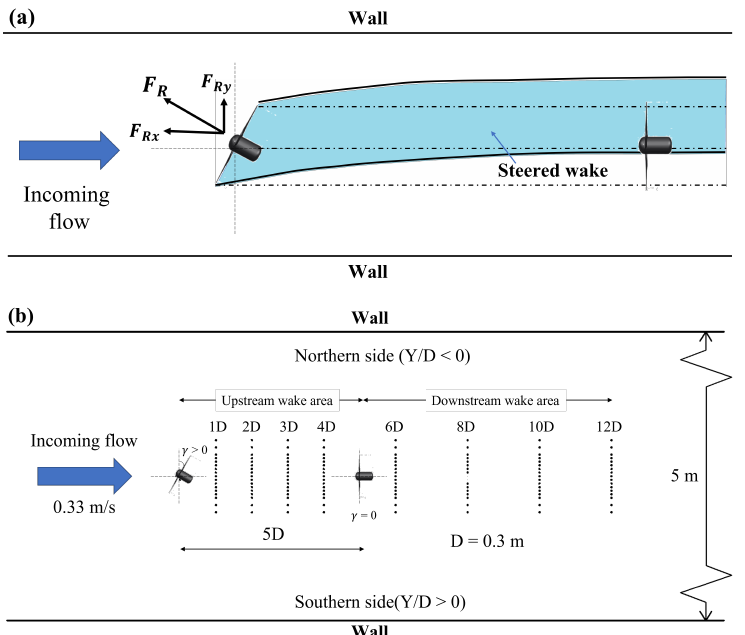
Figure 4. ( a ) Schematic of the yawed turbine thrust force and the assumed wake steering; ( b ) turbine deployments and structure of the sampling grids and the definition of the yaw angle value γ